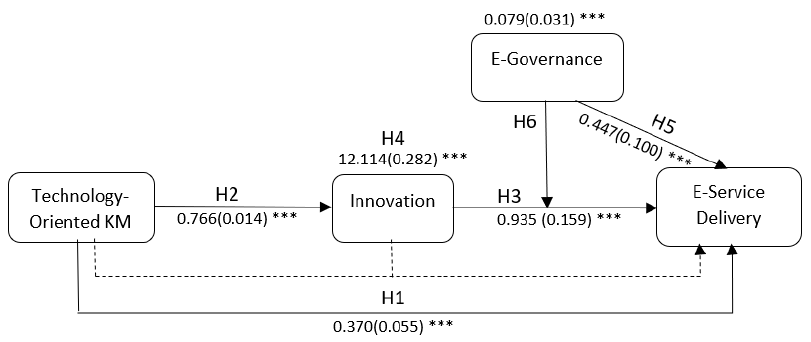
Figure 2. Research outcomes from multiple regression analysis. *** Impact of Technology Oriented KM, Innovation, and E-governance on E-Service Delivery.